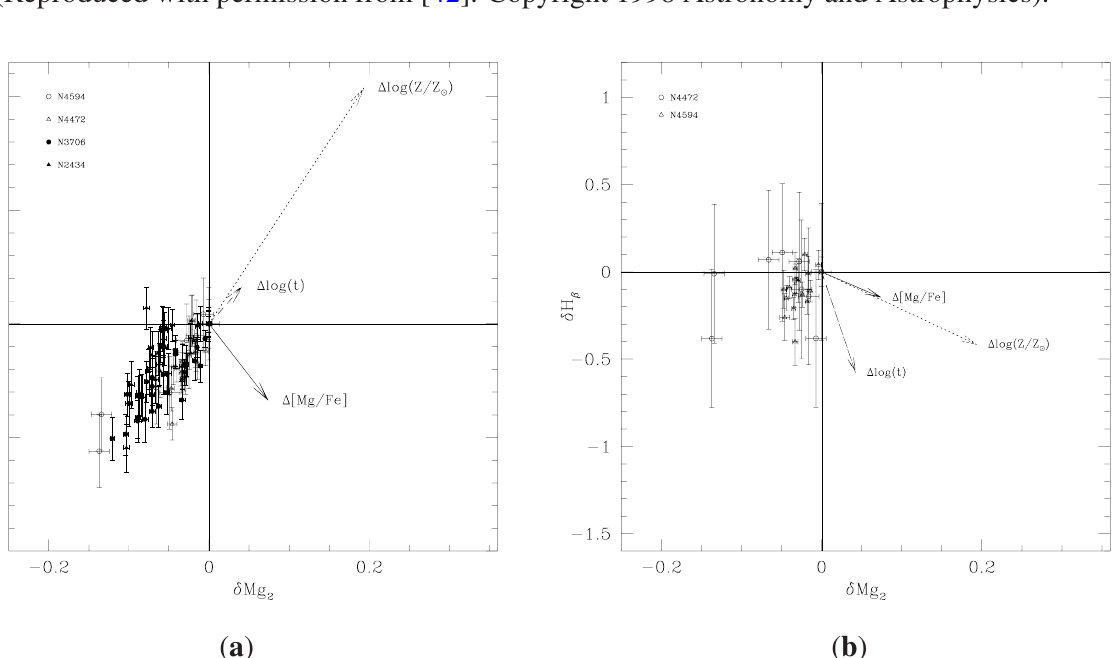
Figure 1. ( a ) The δ versus δ Mg relation across individual galaxies. The three arrows Fe 2 h i centered on (0,0) indicate the age, metallicity, and enhancement vectors as indicated. Along the age vector, the age goes from 5 to 15 Gyr, along the metallicity vector Z ranges from 0.004 to 0.05, and along the enhancement vector [Mg/Fe] goes from 0.3 to 0.4 dex. The − data are from [71] for NGC 4594, from [72] for NGC 4472, and from [10] for NGC 2434 versus δ Mg and NGC 3706; ( b ) The same as in the Left Panel but for the δ H relation. β 2 (Reproduced with permission from [42]. Copyright 1998 Astronomy and